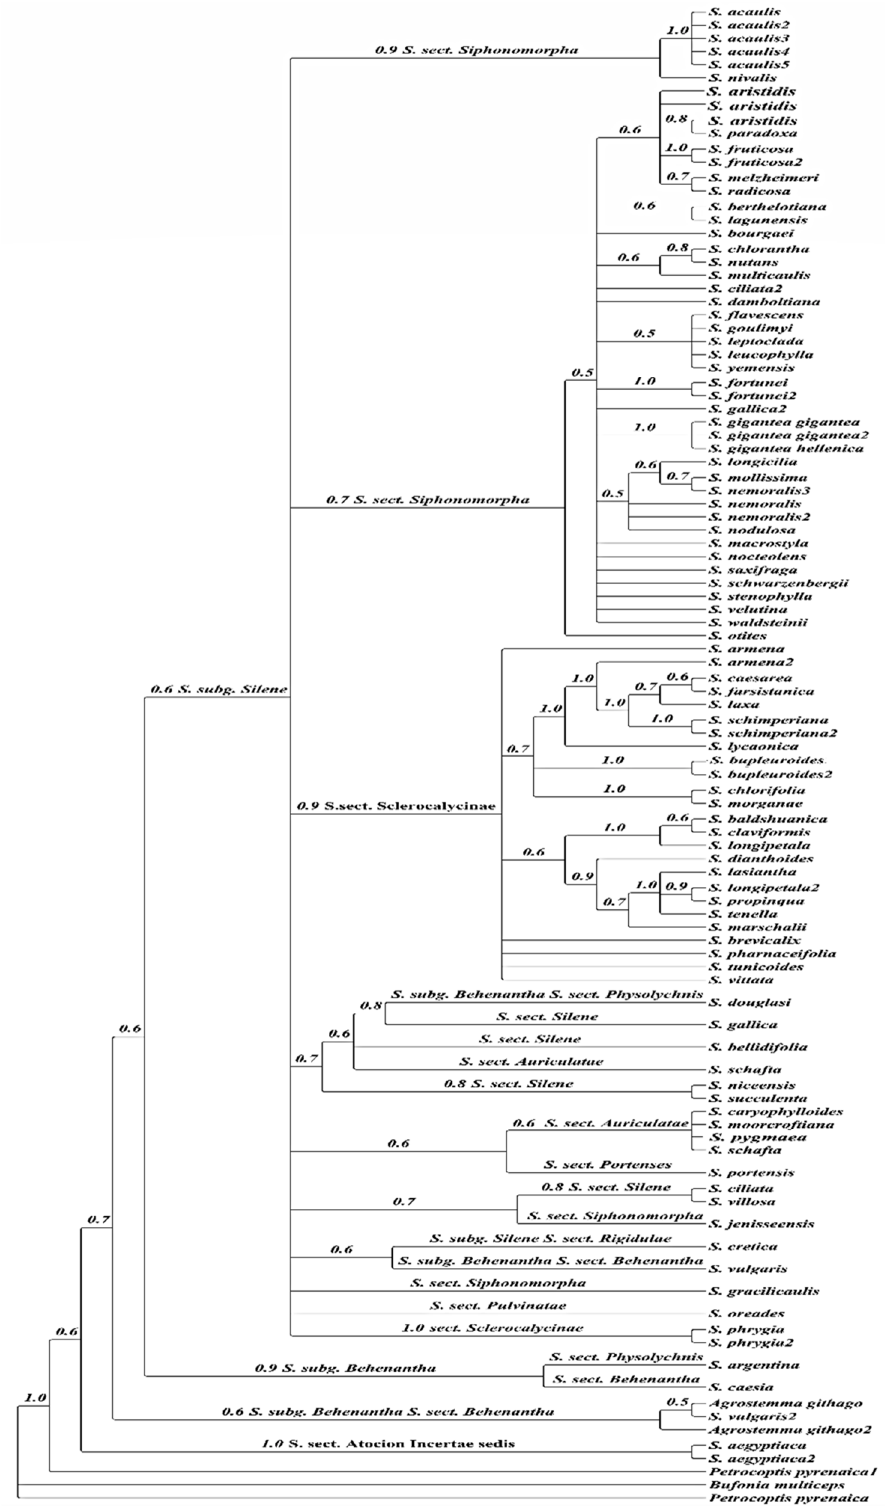
Figure 12. Bayesian cladogram of Silene taxa based on combined DNA sequences of ITS, mat K, psb -A/ trn -H, and rbc L markers. Numbers above branches represented (PP).